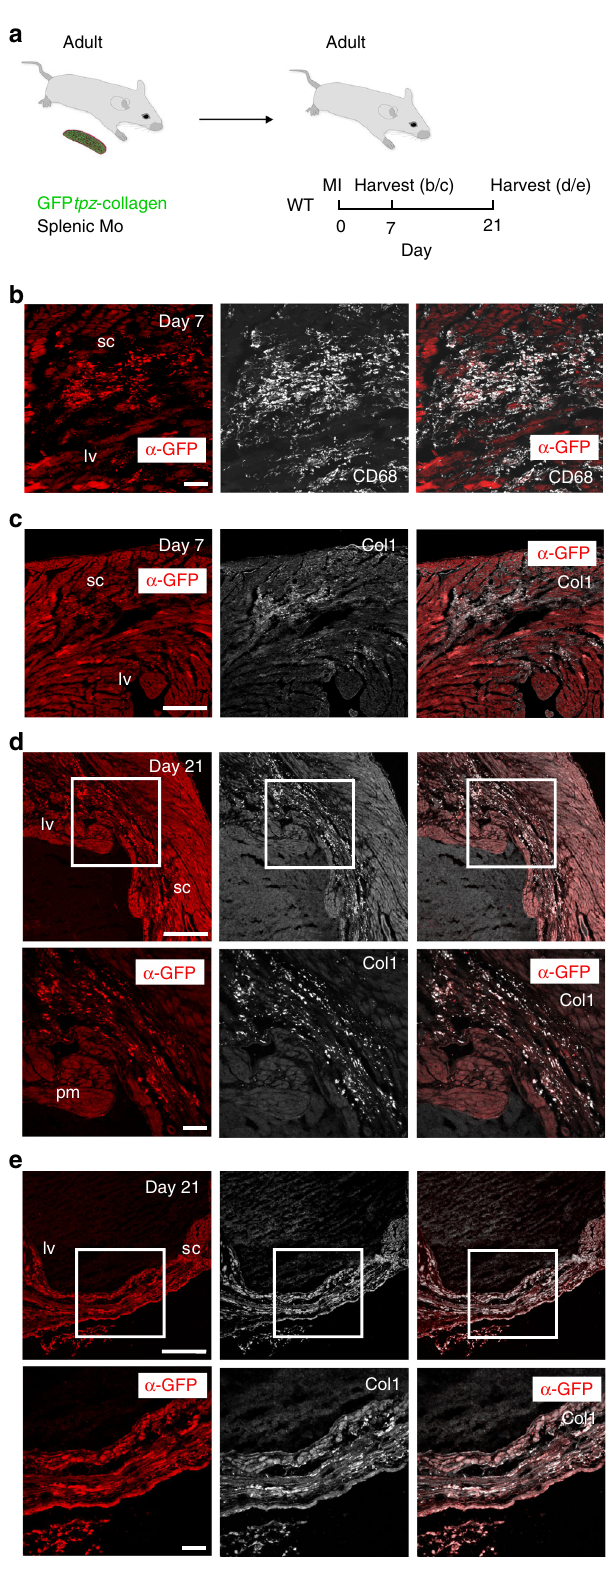
Fig. 3 Adult mouse splenic GFP + monocytes contribute collagen to the scar post-MI. a Experimental design for adoptive transfer: monocytes were isolated by magnetic column puri fi cation from the spleens of adult GFP tpz -collagen + mouse donors. At the time of MI surgery, 50 ± 10 × 10 3 monocytes/PBS, or PBS alone, were transferred to wild type (WT) recipients by intracardiac injection. Adult recipient mice were then harvested at either day 7 ( b , c ) or day 21 ( d , e ) for immunostaining. b At day 7 post-MI, combined immunostaining for α -GFP (red; to exclude auto fl uorescence from monitoring GFP-alone) and α -CD68 revealed GFP + macrophages within the scar region (sc) of the left ventricle (lv). c Co- staining for collagen-1 (white, Col1) revealed GFP + collagen deposits within the same scar region. d By day 21, there was increased GFP + collagen deposition within the scar (white inset boxes in upper panels shown at higher magni fi cation in corresponding panels below). e GFP + collagen fi bres were evident within regions of transmural scar, as detected by combined α -GFP and Col1 staining (white inset boxes in upper panels shown at higher magni fi cation in corresponding panels below). lv, left ventricle, pm, papillary muscle; sc, scar. Scale bars: b , c upper panel, d upper panel 100 μ m; c lower panel, d lower panel 50 μ m. Representative images of n = 3 per